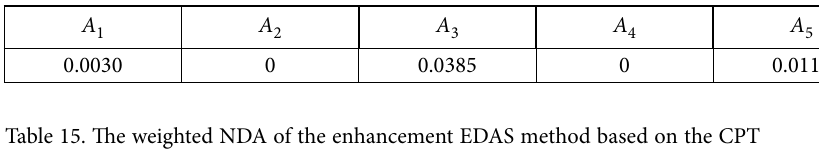
Table 14. The weighted PDA of the enhancement EDAS method based on the CPT